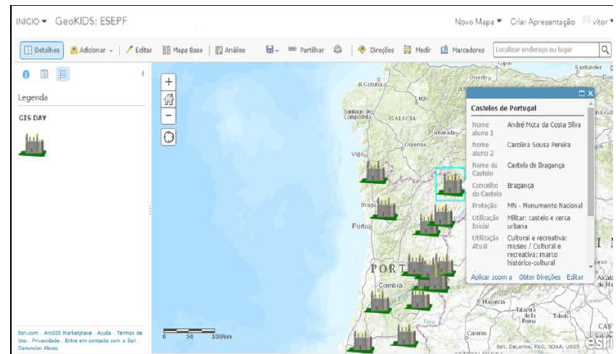
Figure 3 . Collaborative dynamic webmap of Portuguese castles